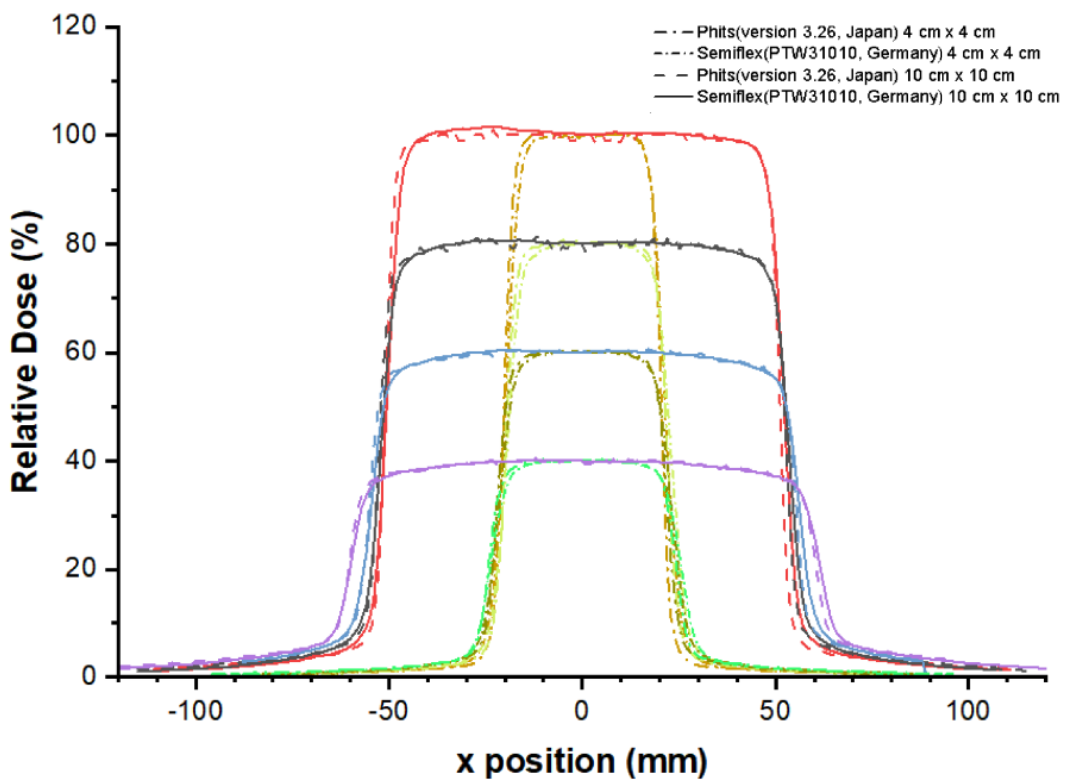
Figure 5. Superimposed beam profiles of measured and simulated values for Varian Clinac 6MV: the cross-plane was evaluated by dividing by field size at 15 mm, 50 mm, 100 mm, and 200 mm depth (4 cm × 4 cm, 10 cm × 10 cm). Table 4. PDD evaluation of measured and simulated values for Varian Clinac 6MV: It was evaluated by dividing by field size (4 cm × 4 cm, 10 cm × 10 cm). For δ 1, which represents fall-off region after build-up area, both field sizes were within the criterion. Additionally, discrepancy of build-up region, δ 2 , was 2 mm and 0 mm,